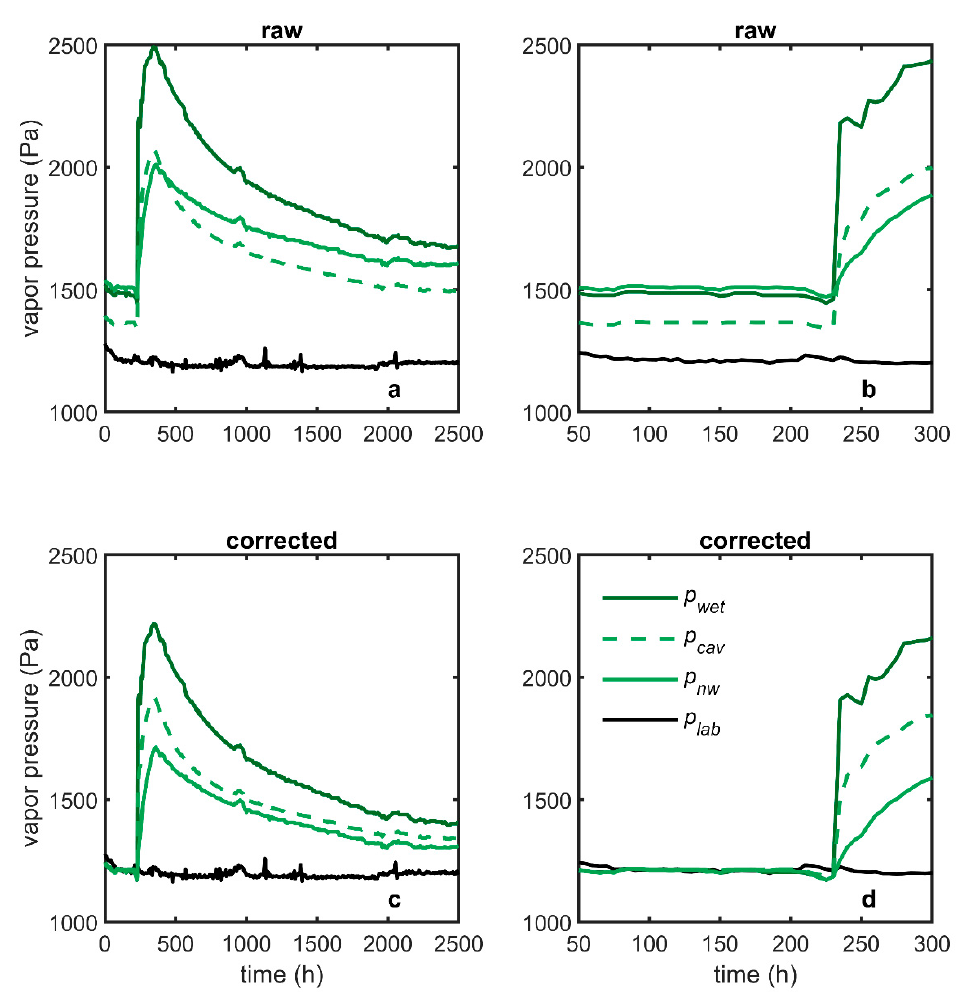
Figure A3. Vapor pressure before and after water injection: raw (uncorrected) values ( a , b ) and corrected values ( c , d ).